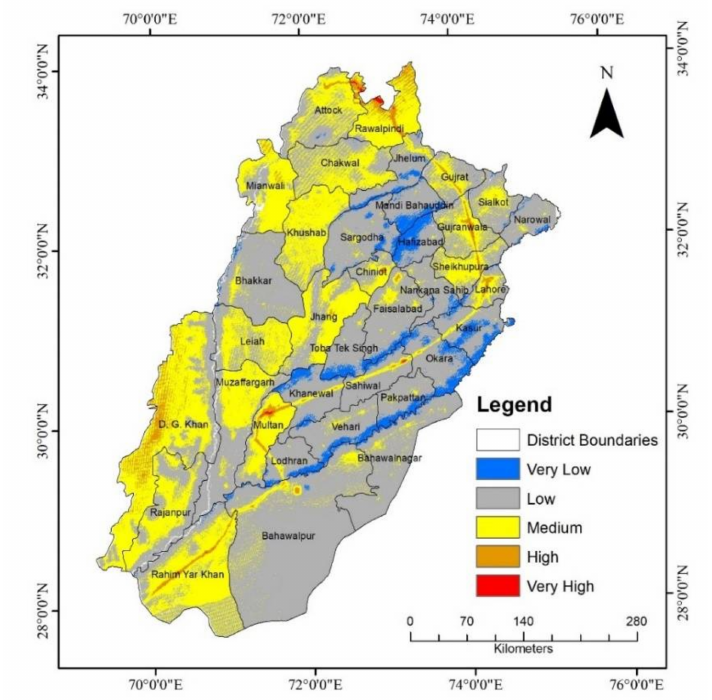
Figure 5. The map of eco-environmental vulnerability in the Punjab province.